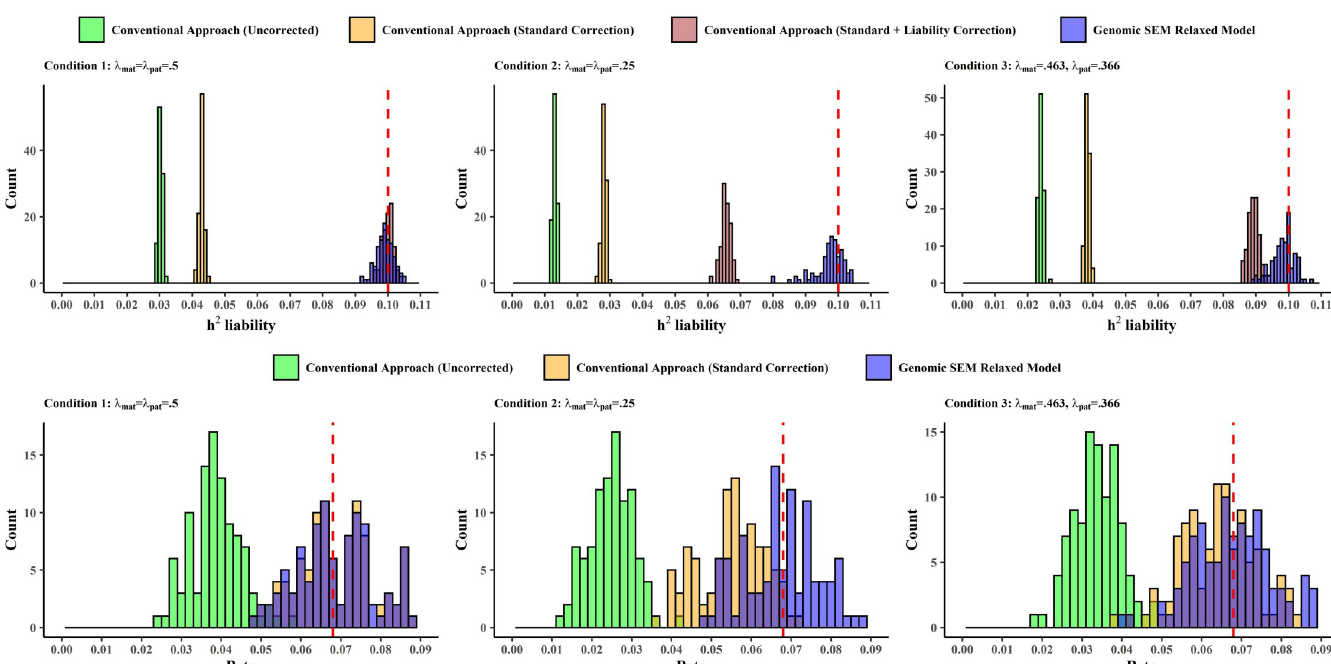
Fig 2. Simulation Results for binary phenotypes. Distribution of liability-scale SNP heritability estimates (top row) and individual SNP effects (bottom row) for Conventional (Uncorrected), Conventional (Standard Correction), Conventional (Standard + Liability Correction), and Genomic SEM Relaxed Model across conditions. The vertical dashed red lines indicate the true parameter value in the population. Complete simulation results for all conditions are reported in S2 and S3 Tables.